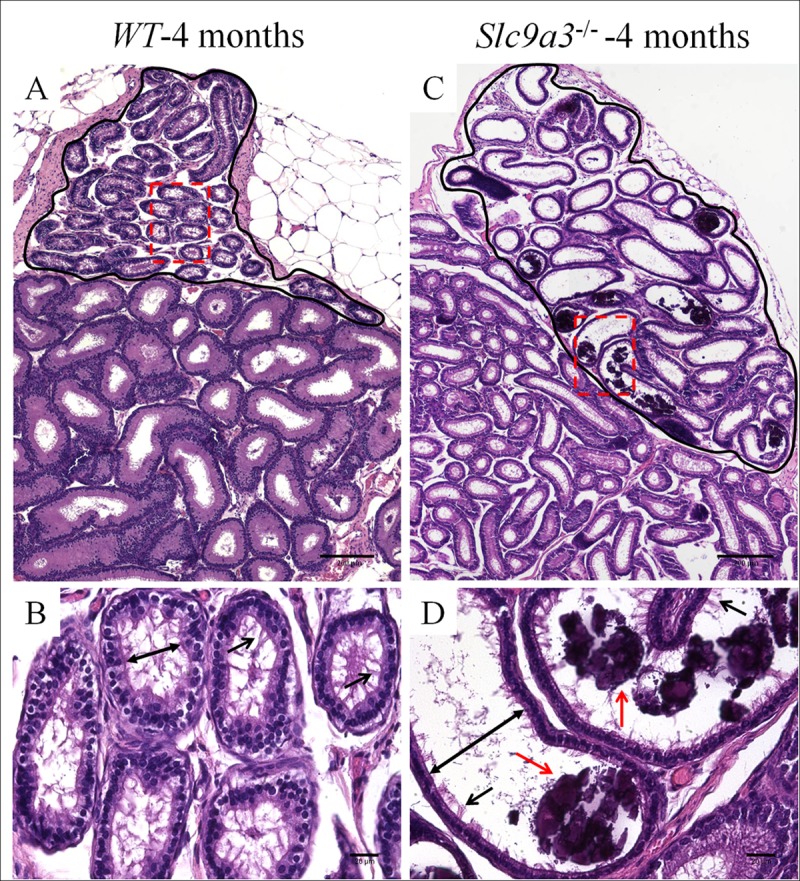
The lumen of the efferent ductules of 4-month-old Slc9a3-/- males is dilated and calcified.Comparison of the efferent ducts of 4-month-old WT (A, B) and Slc9a3-/- (C, D) mice according to H&E staining of the epididymal sections. (A, C) Each representation is a montage assembled by a sequence of film taken with a ×10 objective on the bright-field microscope. The circled region with black solid line in the upper part of the montage is the efferent ductule, and the lower part of the montage is the epididymis. (B, D) Enlarged images from the areas boxed by a red dashed box in the upper panel. The widest distance from one side to the other side of the lumen is marked by double-headed arrows, and cilia on the epithelium are indicated by black arrows. Calcification (red arrow) was observed in some dilated ducts. Scale bar = 200 μm (A, B) and 20 μm (C, D)